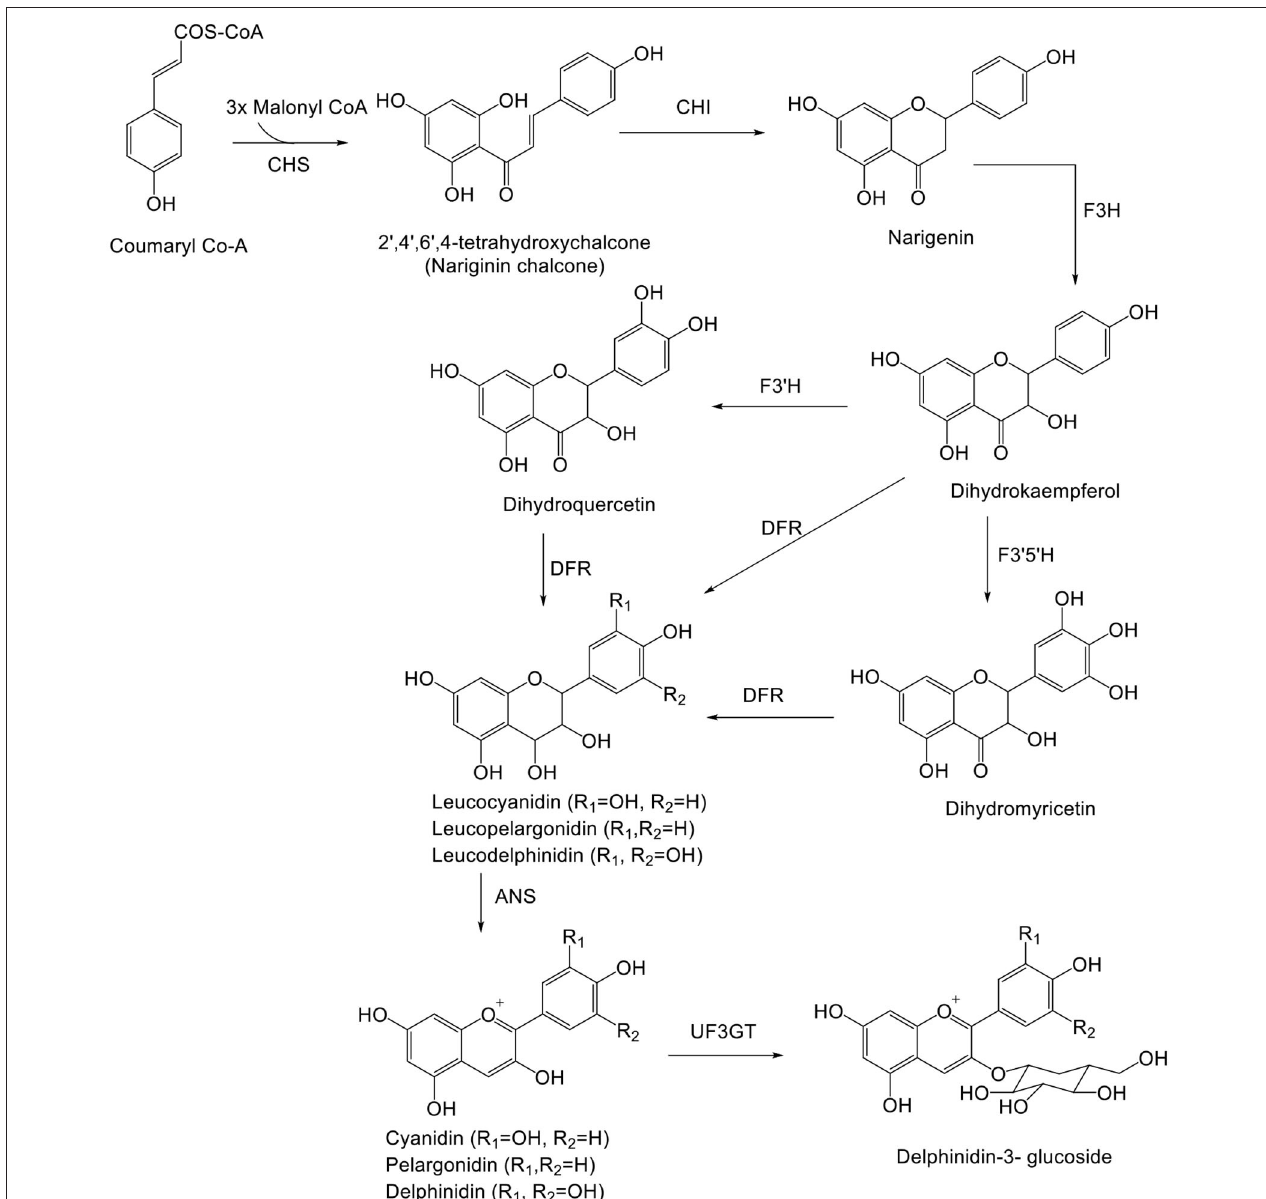
FIGURE 2 | Biosynthetic pathway of delphinidin. ANS, anthocyanidin synthase; CHS, chalcone synthase; CHI, chalcone isomerase; F3H, flavanone 3-hydroxylase; F3 ′ H, flavonoid-3 ′ 5 ′ -hydroxylase; F3 ′ 5 ′ H, flavonoid-3 ′ ,5 ′ -hydroxylase; DFR, dihydroflavonol-4-reductase; UF3GT, UDP-Glc flavonoid 3-O-glucosyl transferase.